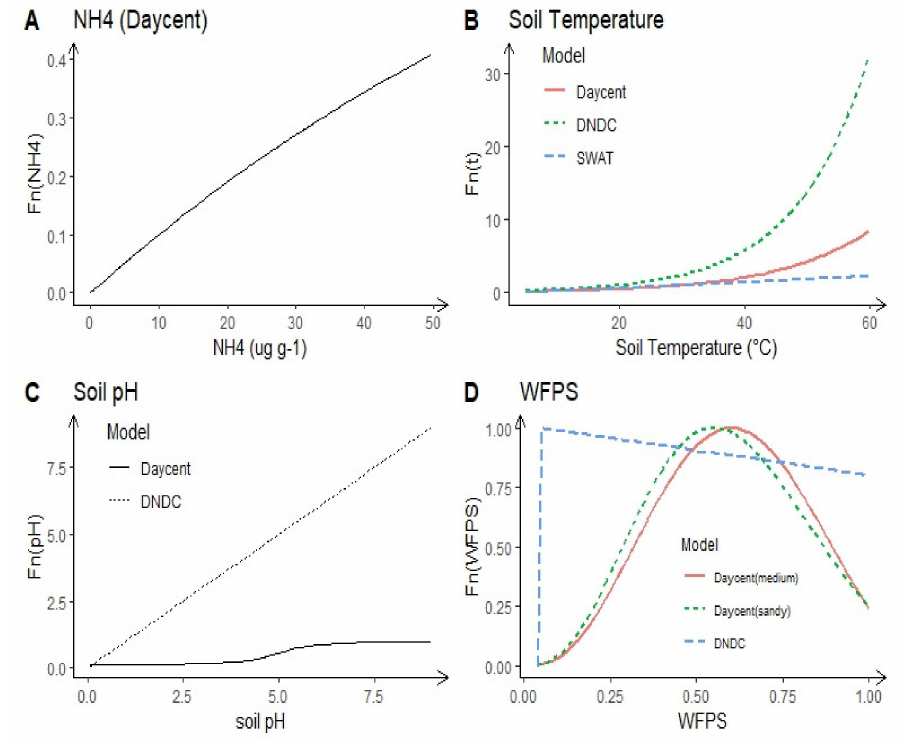
Figure 4. The impact of soil NH 4+ ( A ), soil temperature ( B ), soil pH ( C ) and WFPS ( D ) on nitrification processes in DAYCENT, DNDC and SWAT.